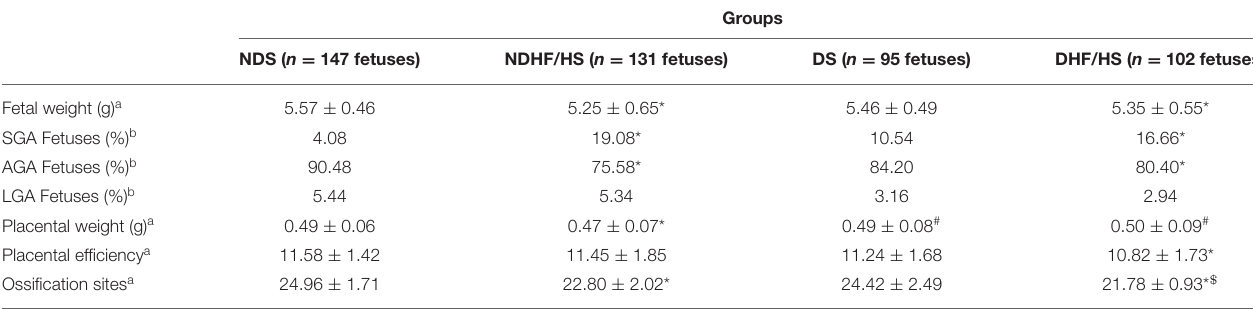
TABLE 5 | Fetal and placental weights, placental efficiency, and ossification sites of fetuses from non-diabetic (ND) and diabetic (D) rats treated or not (S) with high-fat/high-sugar diet (HF/HS) before and during pregnancy.